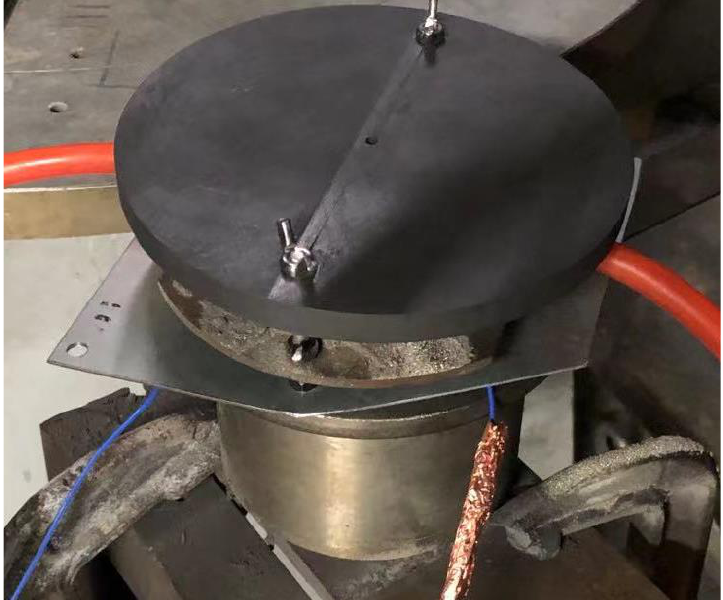
Figure 6. General view of particles temperature measuring